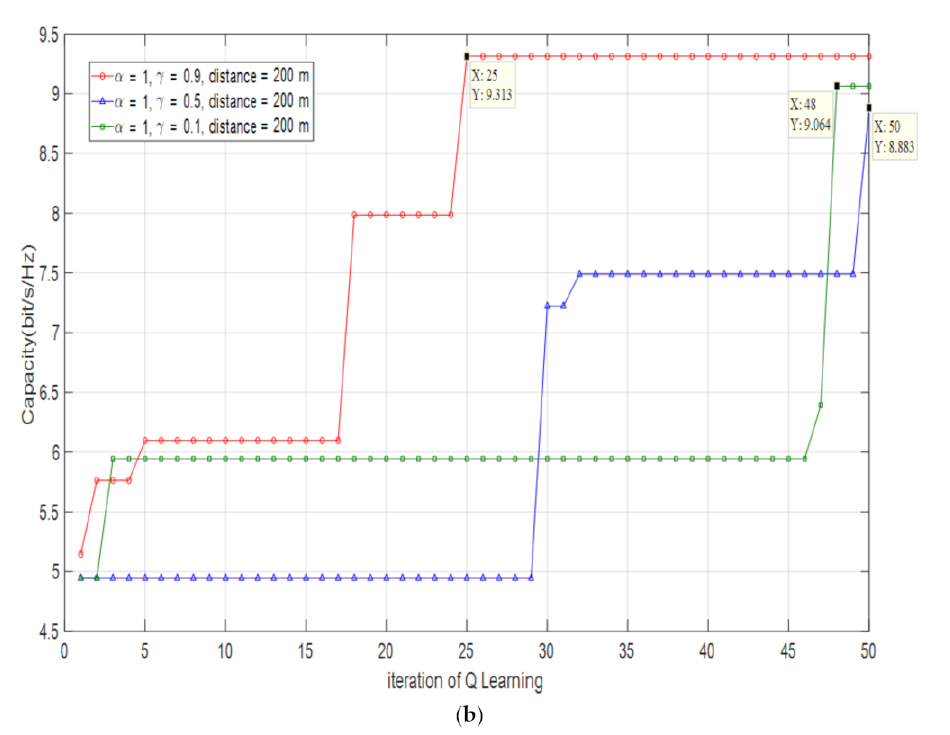
Figure 11. ( a ) Optimized antenna downtilt angle; ( b ) optimized channel capacity. D = 200 m, α = 1 with different γ values.